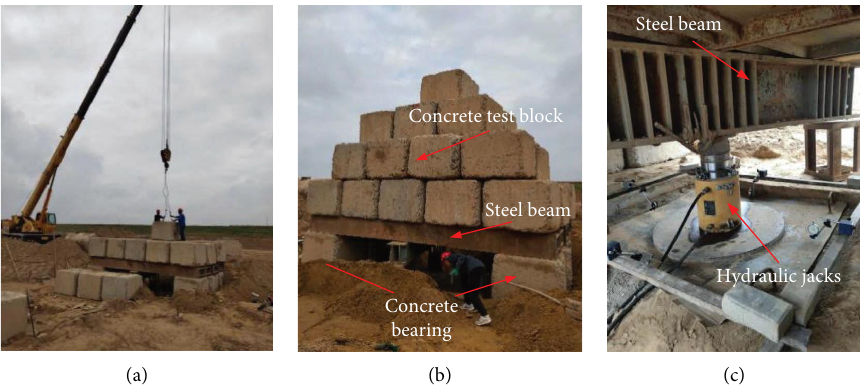
Figure 6: Test equipment diagram: (a) test block lifting; (b) superstructure; (c) substructure.